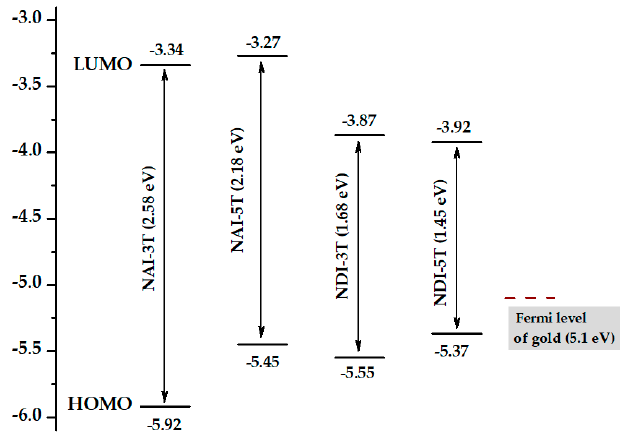
Figure 7. Electrochemically-derived HOMO and LUMO energy levels of 2NDI-nT semiconduc- tors.